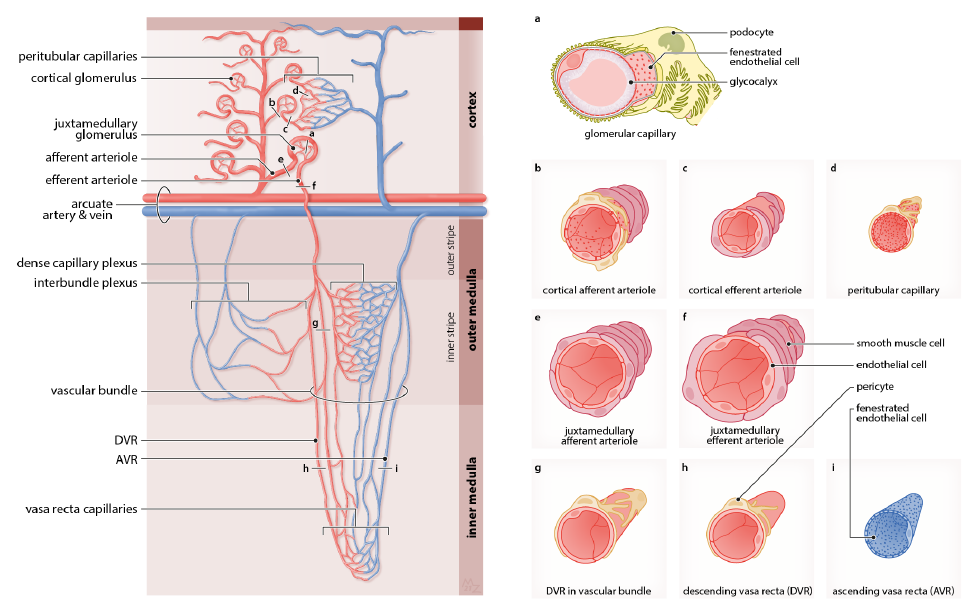
Figure 2. The renal microvascular network exhibits remarkable heterogeneity on morphological and functional level. The ( a ) glomerular capillaries have a fenestrated endothelium and are wrapped by podocytes. The highly muscularized ( b ) cortical afferent arteriole is surrounded by pericytes, in contrast to ( c ) cortical efferent arteriole which contains less smooth muscle cells and flows into the ( d ) peritubular capillaries that are highly surrounded by pericytes. The glomeruli situated close to the arcuate artery and vein are bigger in size, which is reflected by a larger vessel diameter of ( e ) juxtamedullary afferent arteriole and ( f ) juxtamedullary efferent arteriole. The vascular network of the medulla is supplied by efferent arterioles, which arise from the juxtamedullary glomeruli forming a dense capillary plexus and interbundle plexus in the inner stripe of the outer medulla. The ( g ) vascular bundle is wrapped by many pericytes and enter deeper into the inner medulla to form the vasa recta capillaries between the ( h ) descending vasa recta (DVR) and the fenestrated ( i ) ascending vasa recta